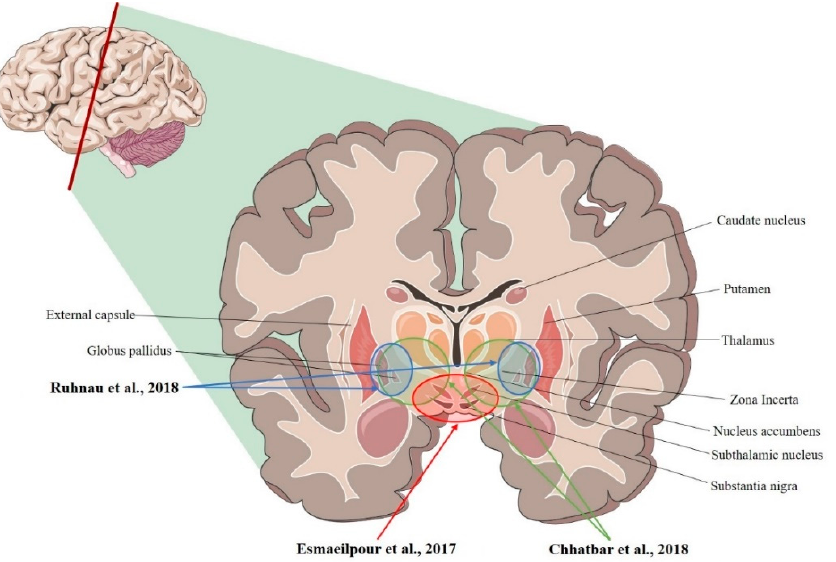
Figure 1. Coronal section of the brain showing the deep brain structures that were targeted for recording. Ruhnau et al., 2018 [36]; Chhatbar et al., 2018 [34]; Esmaeilpour et al., 2017 [37].